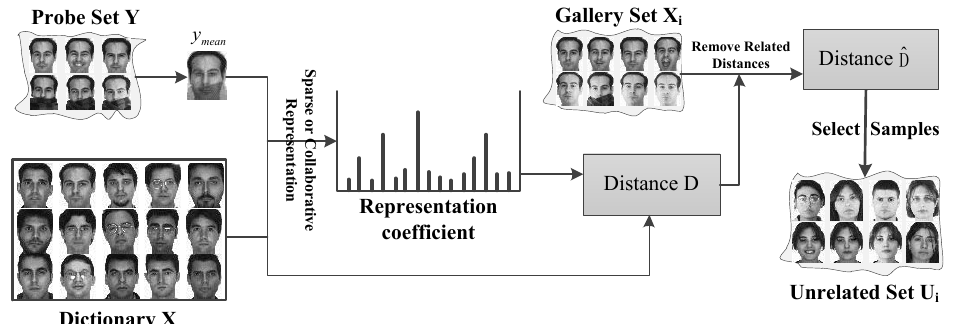
Figure 2. A diagram of the unrelated S3 and S4 set-constructing strategies. In S3, the sparse represen- tation is used to learn the distances, while in S4, the collaborative representation is